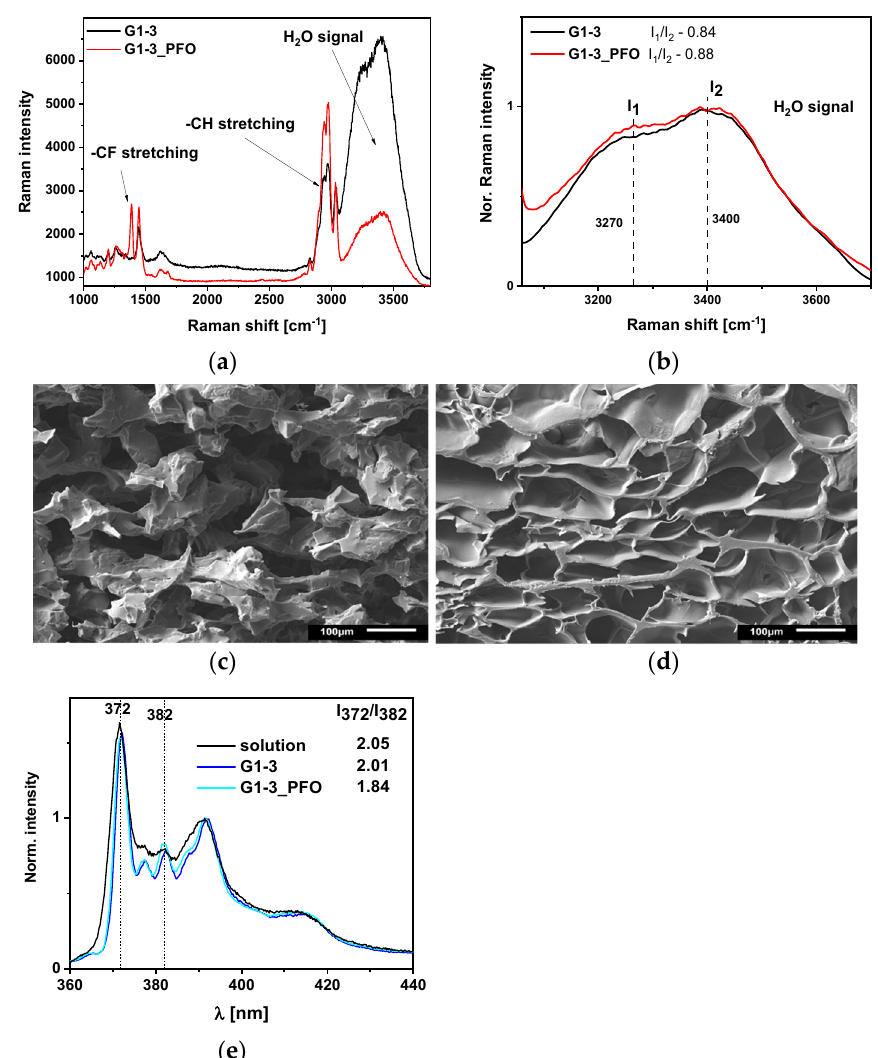
Figure 5. ( a ) Raman signals in the range of 1000–3800 cm − 1 of the G1-3-Cl and G1-3-PFO gels at 100 µm below the gel surface; ( b ) Raman signal of the water stretching in the range of 3200–3800 cm − 1 of the G1-3-Cl and G1-3-PFO hydrogels. The signal is normalized by weak water interaction vibrations at 3400 cm − 1 . Scanning electron microscopy (SEM) images of ( c ) the G1-3-Cl and ( d ) G1-3-PFO xerogels; ( e ) the fluorescence emission of pyrene (c = 1 × 10 − 5 M) in solution, the G1-3-Cl and G1-3-PFO gels, and an excitation of 344 nm in water/MeOH (1/1, v/v ). The spectra were normalized at the 392 nm emission band.